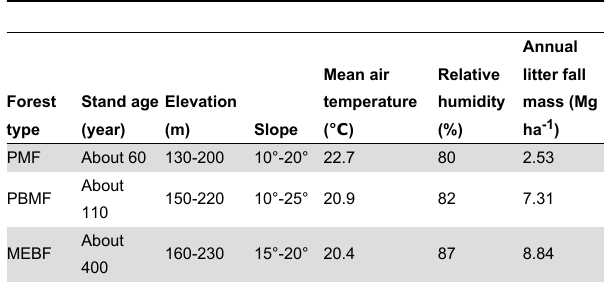
Table 1. Characteristics of the sampling sites representing a succession